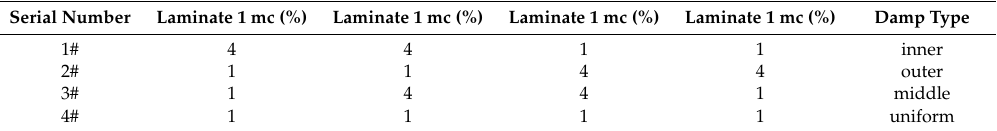
Table 2. Radial moisture distribution of oil-polymer insulated bushing model.